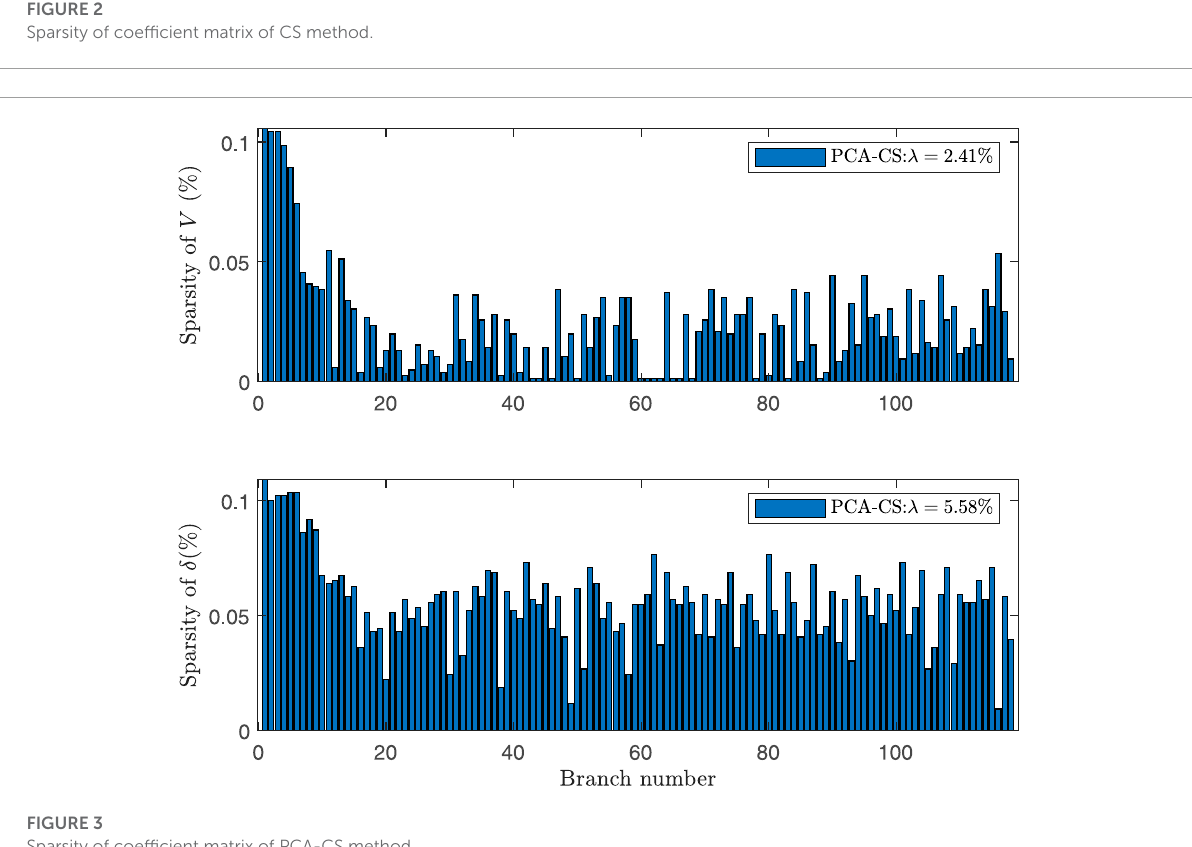
FIGURE 3 Sparsity of coefficient matrix of PCA-CS